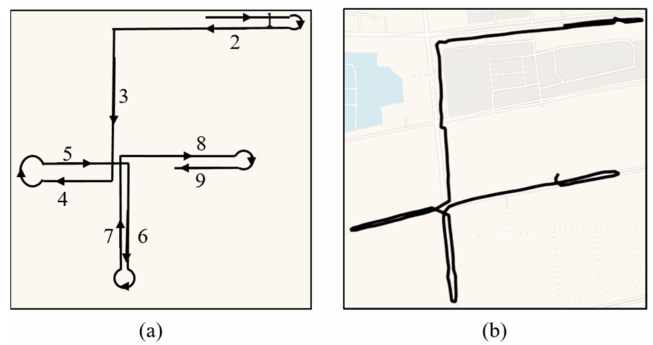
Figure 2. The schematic ( a ) and actual trajectory ( b ) of aimlessly wandering. Each curve in ( a ) corre- sponds to a large directional change.